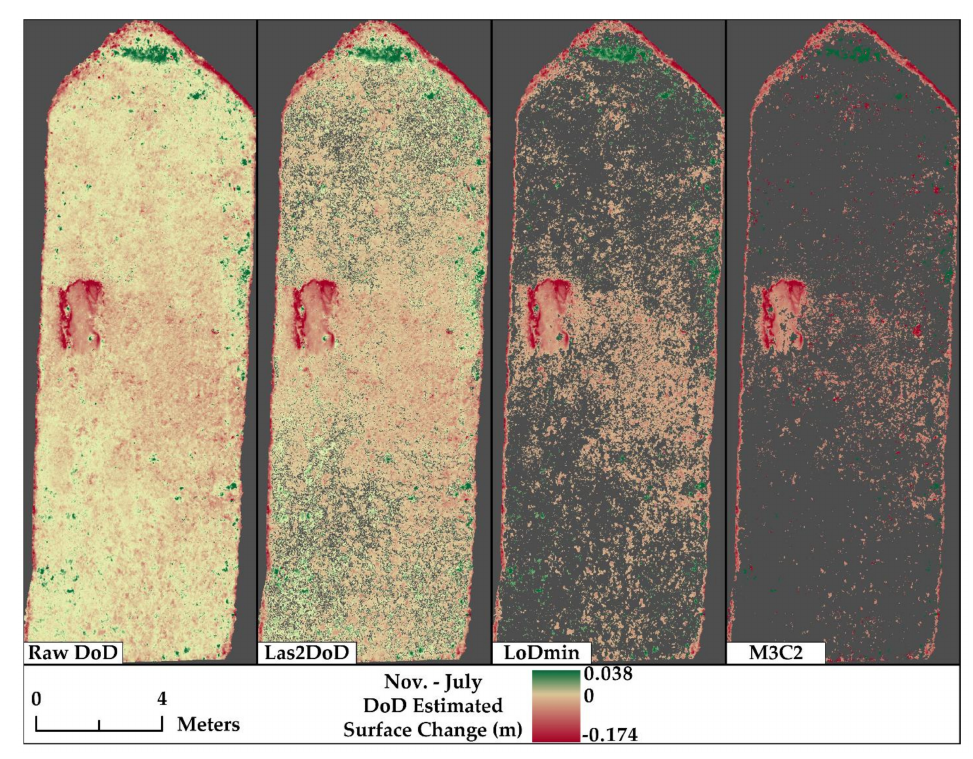
Figure 5. DoD results from Plot A of a DoD without uncertainty analysis and the three tested methods with uncertainty